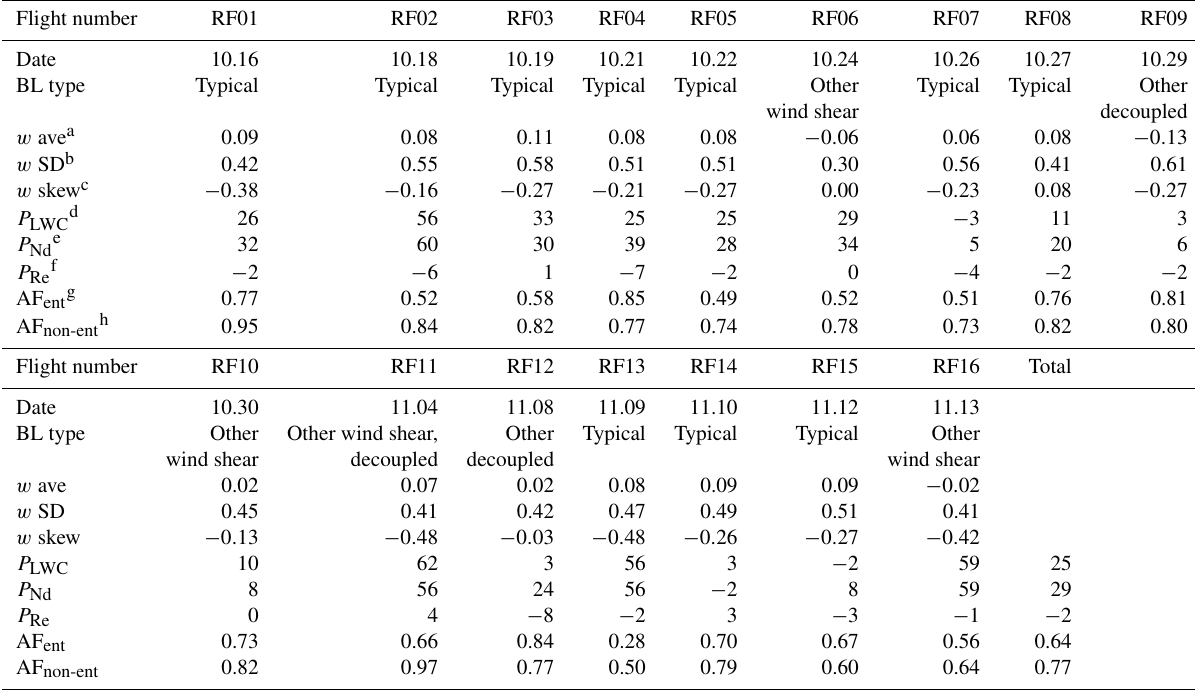
Table 2. Flight information and parameters that represent the properties of entrainment during all 16 non-drizzling flights. Flight number